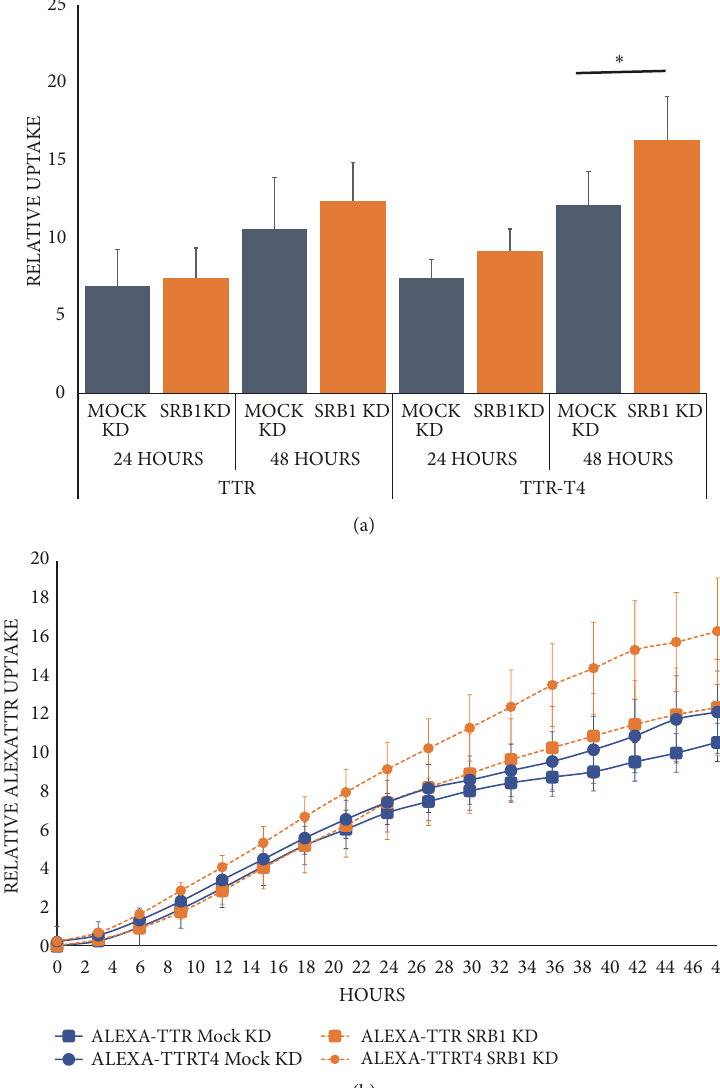
Figure 4: Scavenger receptor Class B Type 1 (SR-B1) levels affect uptake of Alexa-TTR-T4 by HepG2 cells. (a) Knockdown of SR-B1 levels (to 29 ± 8% of mock control levels) prior to uptake experiments resulted in increased ( ∼ 133%) uptake of Alexa-TTR-T4 at 48 hours compared to control. (b) Comparison of Alexa-TTR (square) uptake in mock control (blue) versus SR-B1 knockdown (orange) cells and of AlexaTTR-T4 (circle) uptake in mock control versus SR-B1 knockdown cells (all n=4, ∗ p <